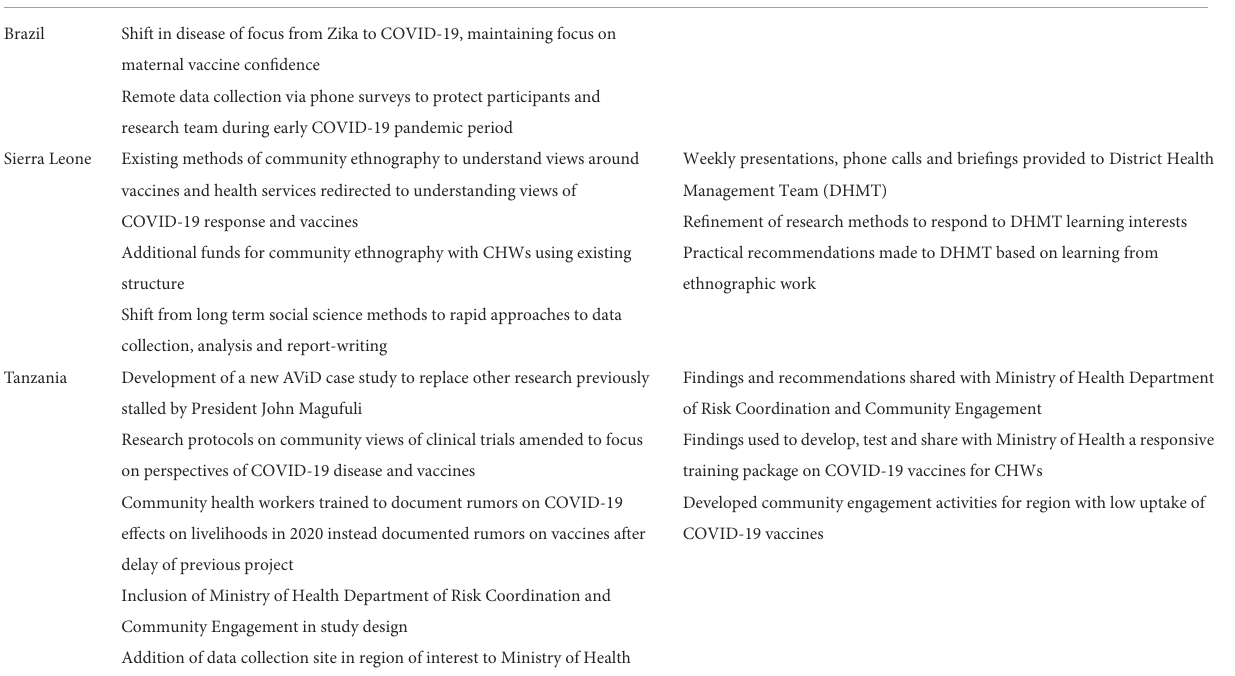
TABLE 2 AViD case studies adaptations to COVID-19.